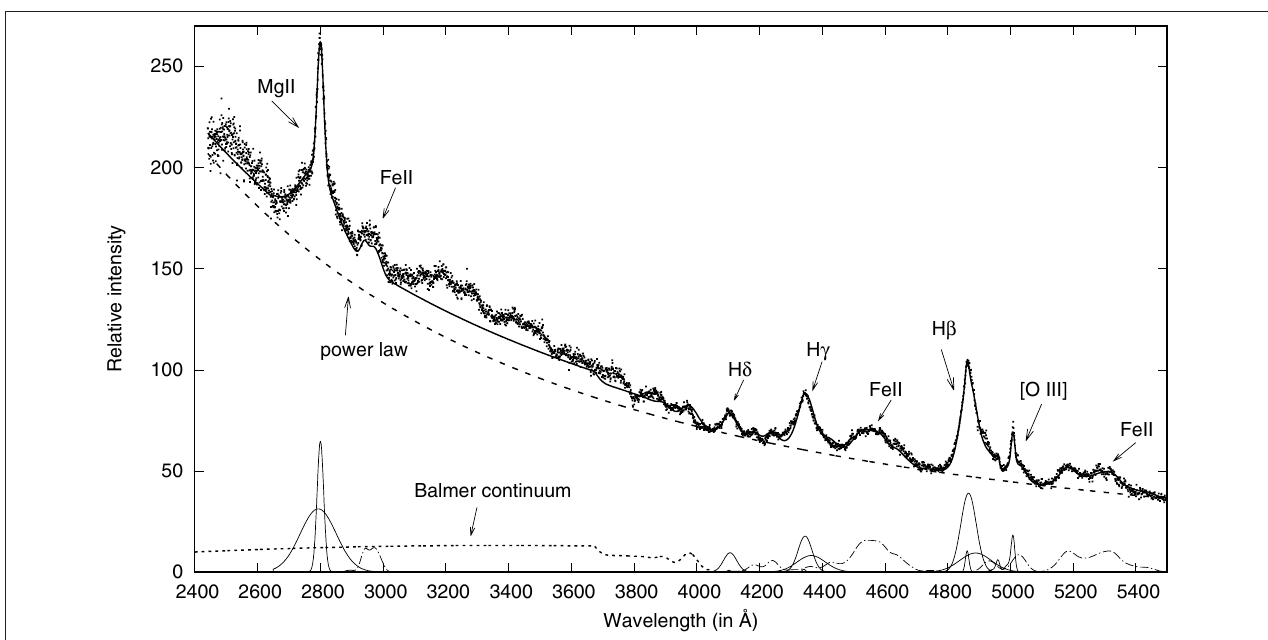
FIGURE 1 | The example of the decomposition of the UV-optical pseudo-continuum (power law + Balmer continuum) and emission lines in ranges 2,650–3,050Å and 4,000–5,500Å for object SDSS J014942.50 + 001501.7. The observations are denoted with dots, the sum of pseudo-continuum and emission line model with solid line, and the power law continuum with dashed line. Bellow, the Balmer continuum is given with dotted line, and UV/optical Fe II templates with dotted-dashed line and all emission lines with solid